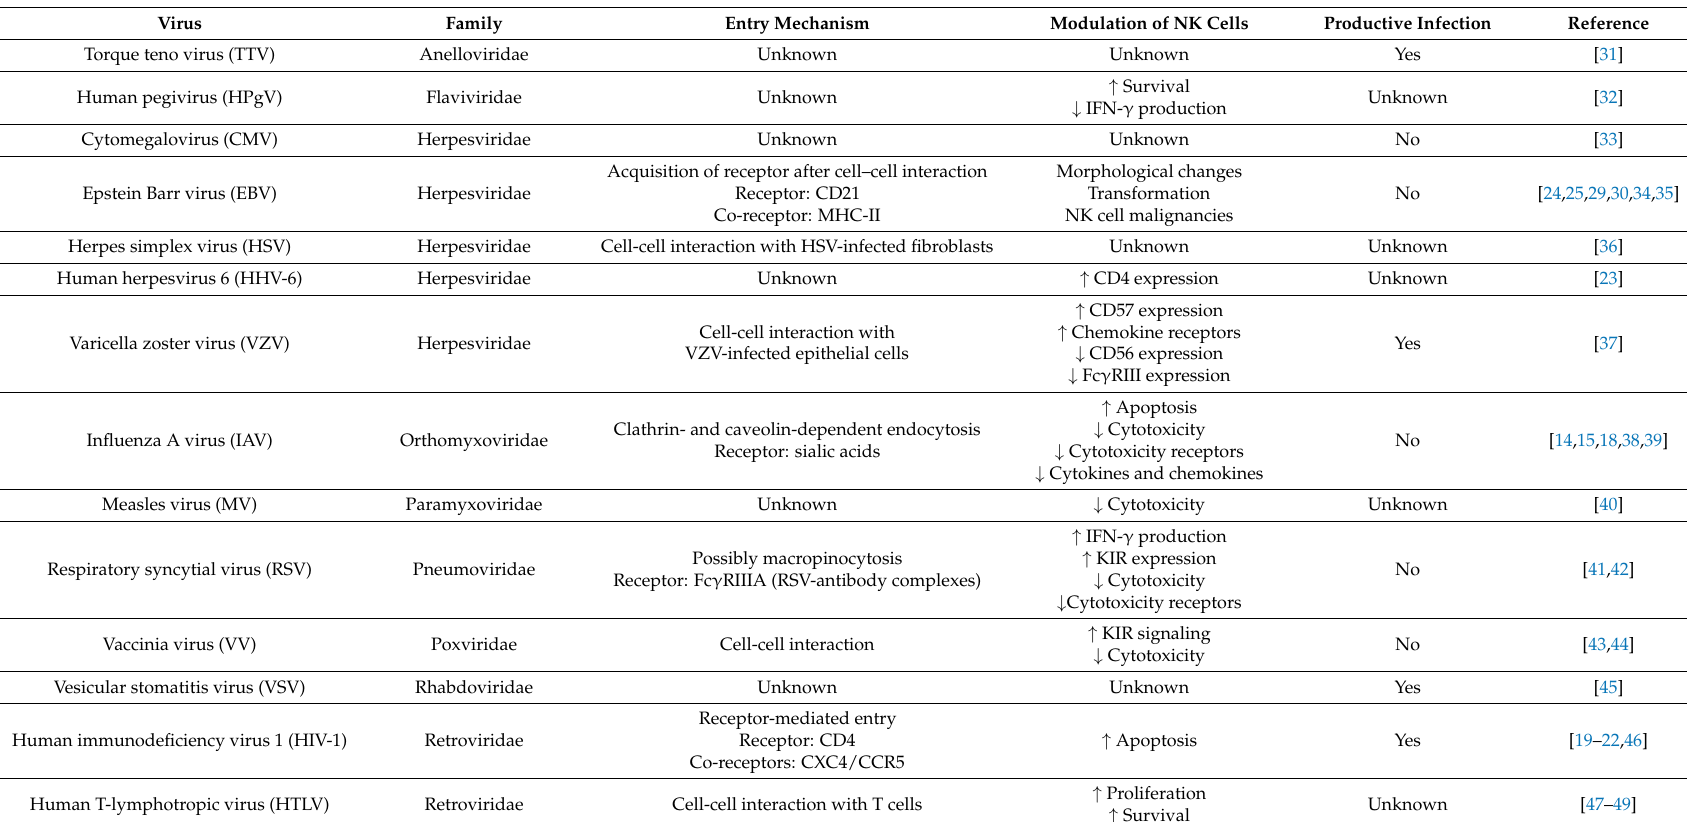
Table 1. Overview of viruses known to infect natural killer (NK)